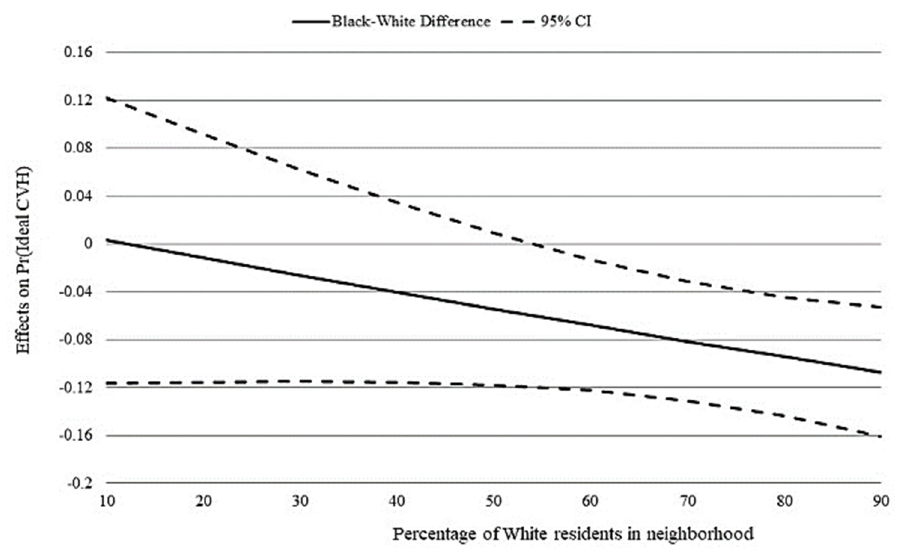
Figure 2. Figure graphically depicts race differences in ideal CVH along thresholds of racial residen- tial segregation. Graph is based on Model 4 of Table 2. (2) Race differences in the marginal effect of percentage of White residents in neighborhood on ideal cardiovascular health (CVH). Dashed lines give 95% confidence interval (CI).